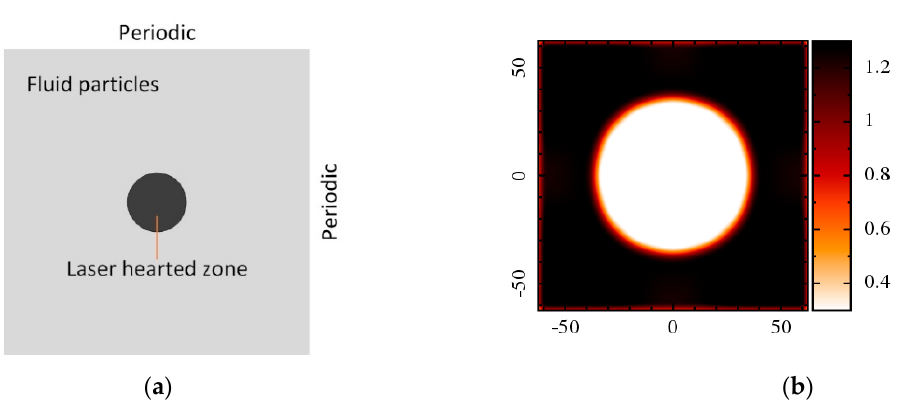
Figure 1. ( a ) Initial calculation domain; ( b ) snapshot of the vapor-filled laser-induced bubble.